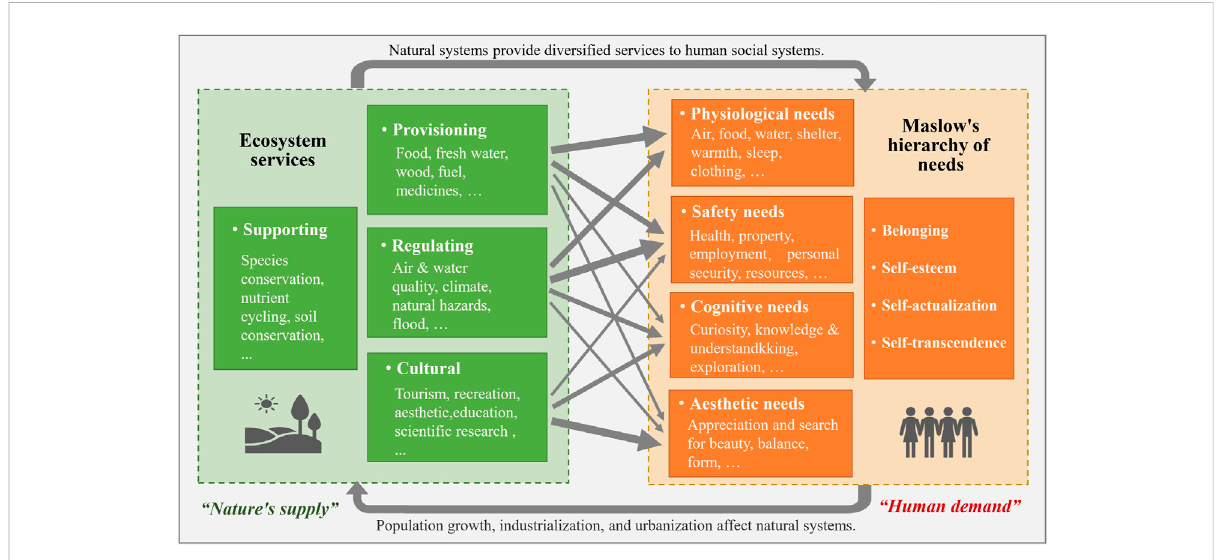
FIGURE 1 Relationsbetweensupplyanddemandincoupledhumanandnaturalsystems.Note:Arrow ’ swidthrepresentstheintensityoflinkagesbetween ecosystem services and human